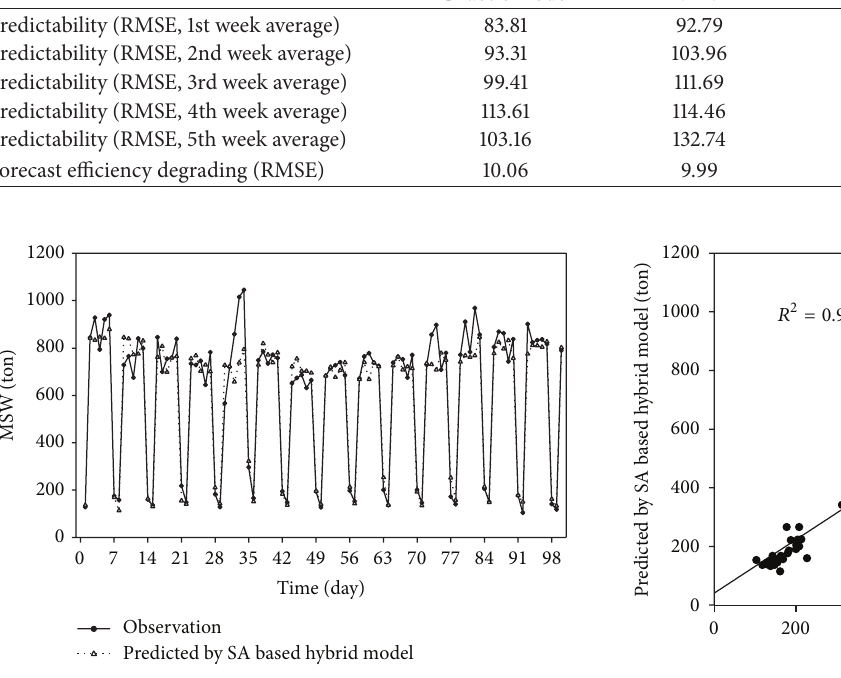
Figure 3: Forecast results by SA based hybrid model of one step ahead prediction. Time span covers the last 100 days.